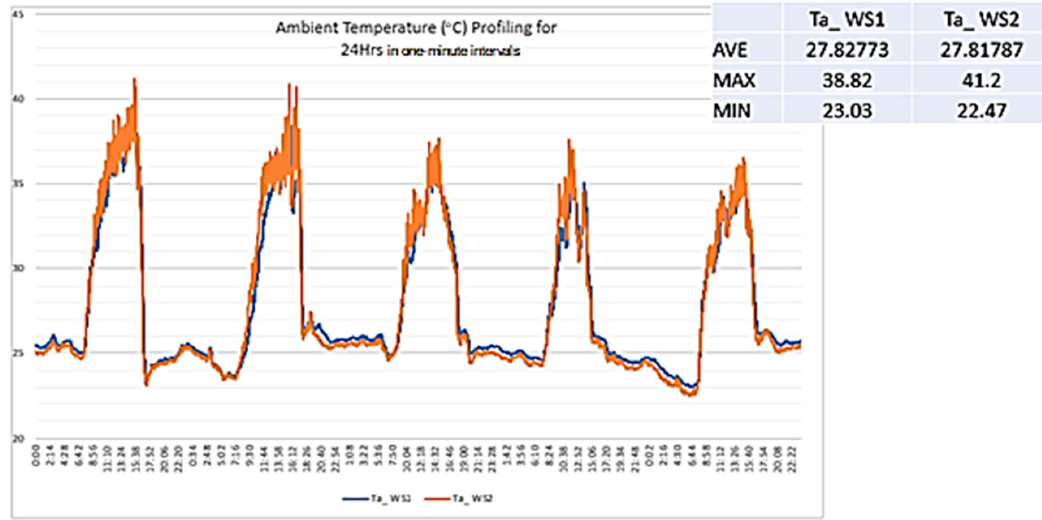
Figure 9. Ambient temperature pro fi ling.